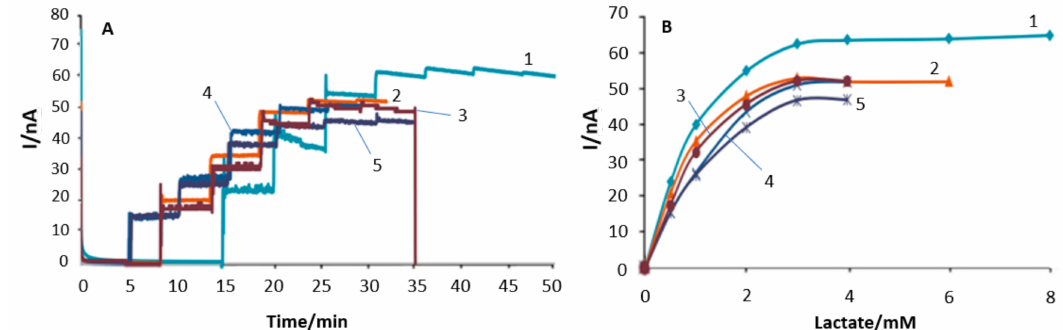
Figure 3. Lactate step change responses of five independently fabricated Pt–stainless steel needle electrodes using an identical protocol. Electrodes numbered (1–5) refers to the corresponding electrode with respect to dynamic response ( A ) and the resulting calibration using the steady state response ( B ). Protocol used albumin crosslinked lactate oxidase (LOx) from Pediococcus sp. Measurements in PBS pH 7.4 under rapid stirred conditions where response is independent of stirring rate. Responses normalized to a zero baseline currents. (Mean maximum response 50.3 nA, CV 6.2%).